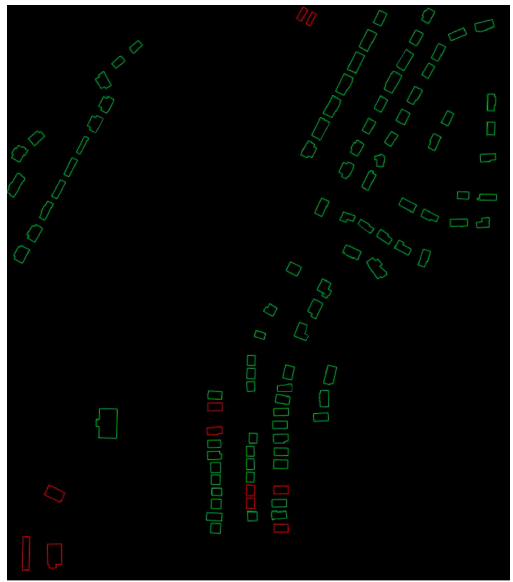
Figure 11. Unchanged buildings are shown by green color and changed buildings (newly built) are shown in red.